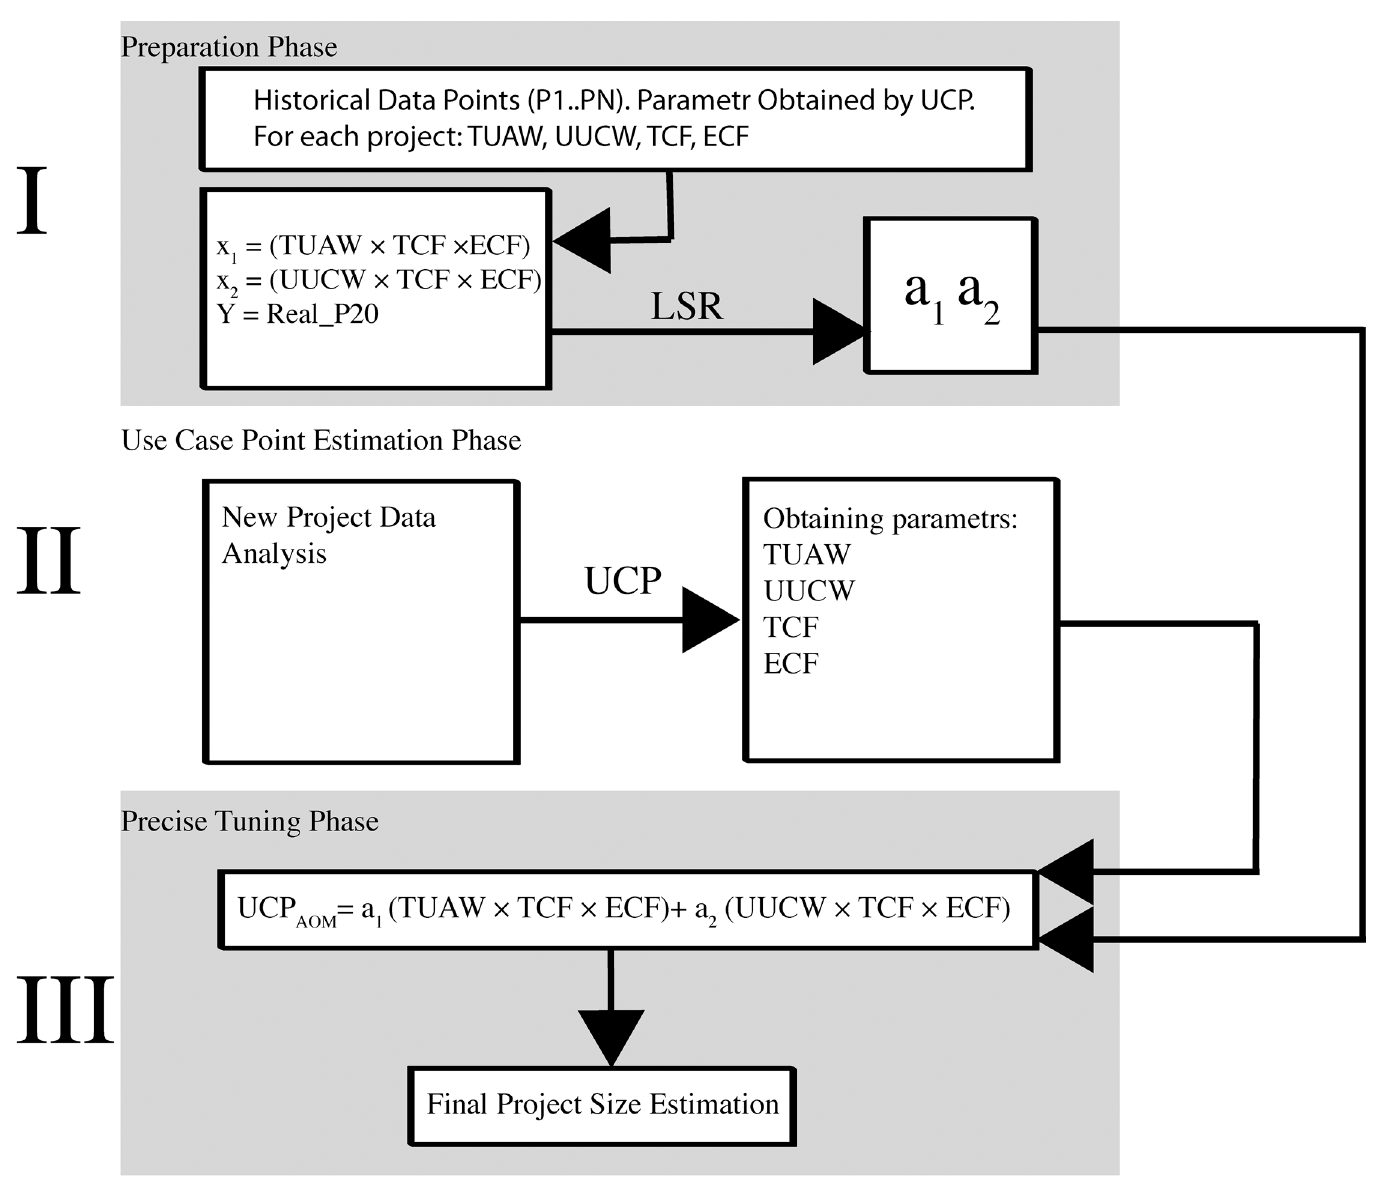
Fig 1. Algorithmic Optimisation Method